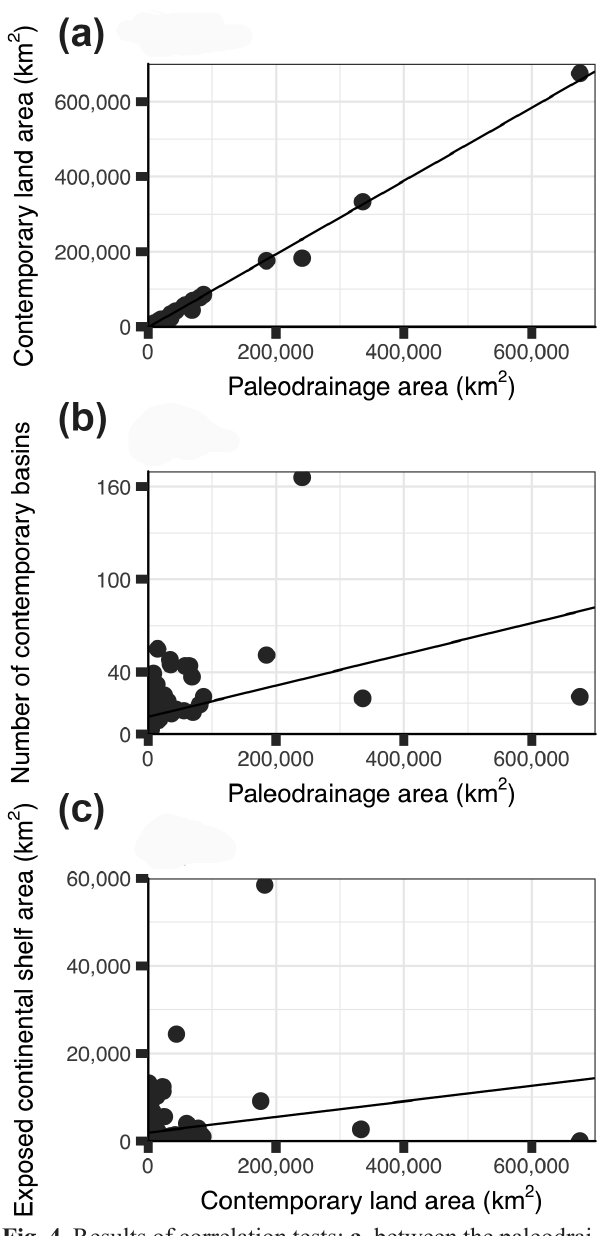
Fig. 4. Results of correlation tests: a. between the paleodrai- nage total area with contemporary land area encompassed by each paleodrainage ( r 2 = 0.99; P < 0.0001); b. the number of contemporary basins encompassed by each paleodrainage ( r 2 = 0.17; P < 0.0001); and c. between the contemporary land area and the area of the continental shelf exposed du- ring the drop in sea level ( r 2 = 0.04; P = 0.01). Individual values per paleodrainages are given in Tab.